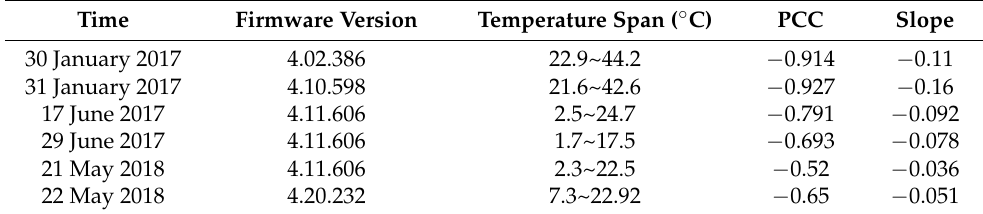
Figure 11. Receiver DCB variations (blue lines) at station ALIC, as estimated with the MCCL method for various receiver firmware versions and various temperature conditions. The intraday temperature values (red lines) were extracted from IGS meteorological data. PCC denotes the Pearson correlation coefficient between the blue line and the red line. Table 3. Factors influencing the intraday variability of the receiver DCBs at station ALIC, with a LEICA GR25 receiver and a LEIAR25.R3